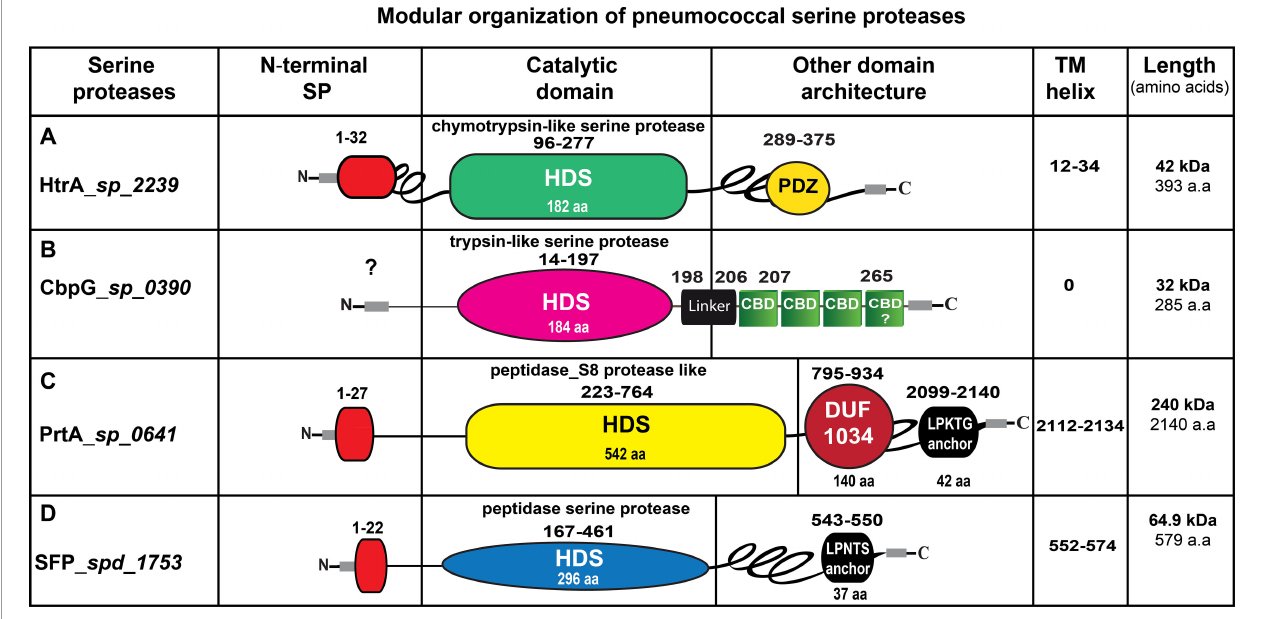
FIGURE 2 | Schematic presentation of the modular organization in pneumococcal serine proteases. (A) HtrA (AAK76286.1), the signal peptide sequences (aa 1-32) are illustrated in red. The serine protease catalytic domain is shown in light green, PDZ domain is labeled in yellow. (B) CbpG (AAK74556.1), most likely has no signal peptide. The trypsin-like serine protease catalytic domain is shown in pink, the repeats of the choline-binding domains (CBDs) are marked in green, connected by short linker region aa 198-206. The C-terminal region aa 267-285 is probably also involved in binding to choline residues of teichoic acids. (C) PrtA (AAK74791.1), the signal peptide sequence aa 1-27 is depicted in red, the serine protease catalytic domain is illustrated in yellow, the DUF 1034 domain is shown in red. The C- terminal anchoring motif is labeled in yellow. (D) SFP (ABJ54257.1), the signal peptide sequence (1-22 aa) is shown in red, the serine protease catalytic domain is marked in blue. The length of each serine protease is given as the number of amino acids (aa). HDS, histidine, aspartate and serine; TM, transmembrane domain; SP, signal peptide